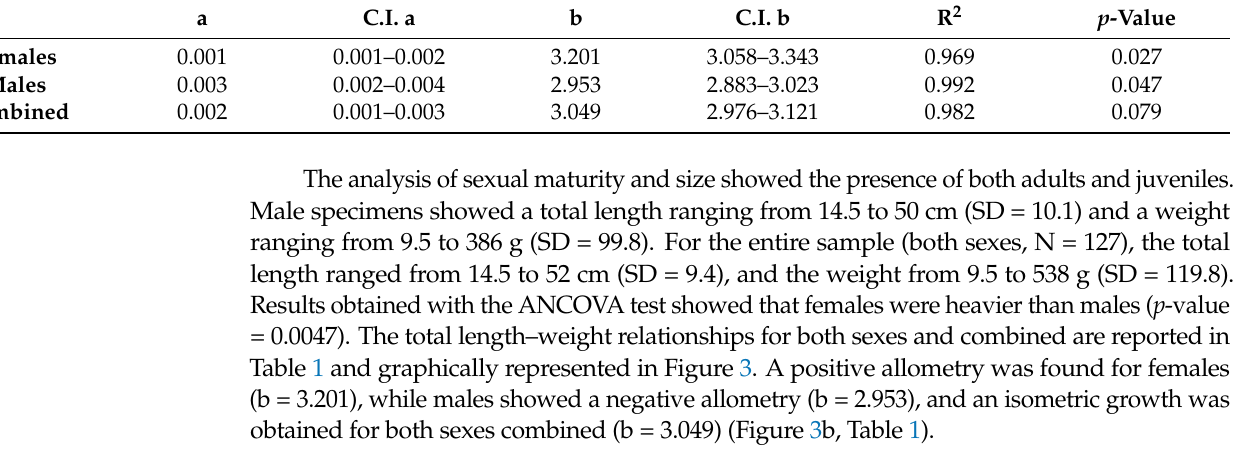
Figure 2. Sex composition by size classes of G. melastomus : ( a ) male; ( b ) female. Table 1. Total length–weight relationship parameters of G. melastomus in the Tyrrhenian Sea (western Mediterranean Sea); “a” represents the values of the intercept, and “b” is the slope of the logarithmic regression curve. C.I. = 95% confidence interval. Length–Weight Relationship